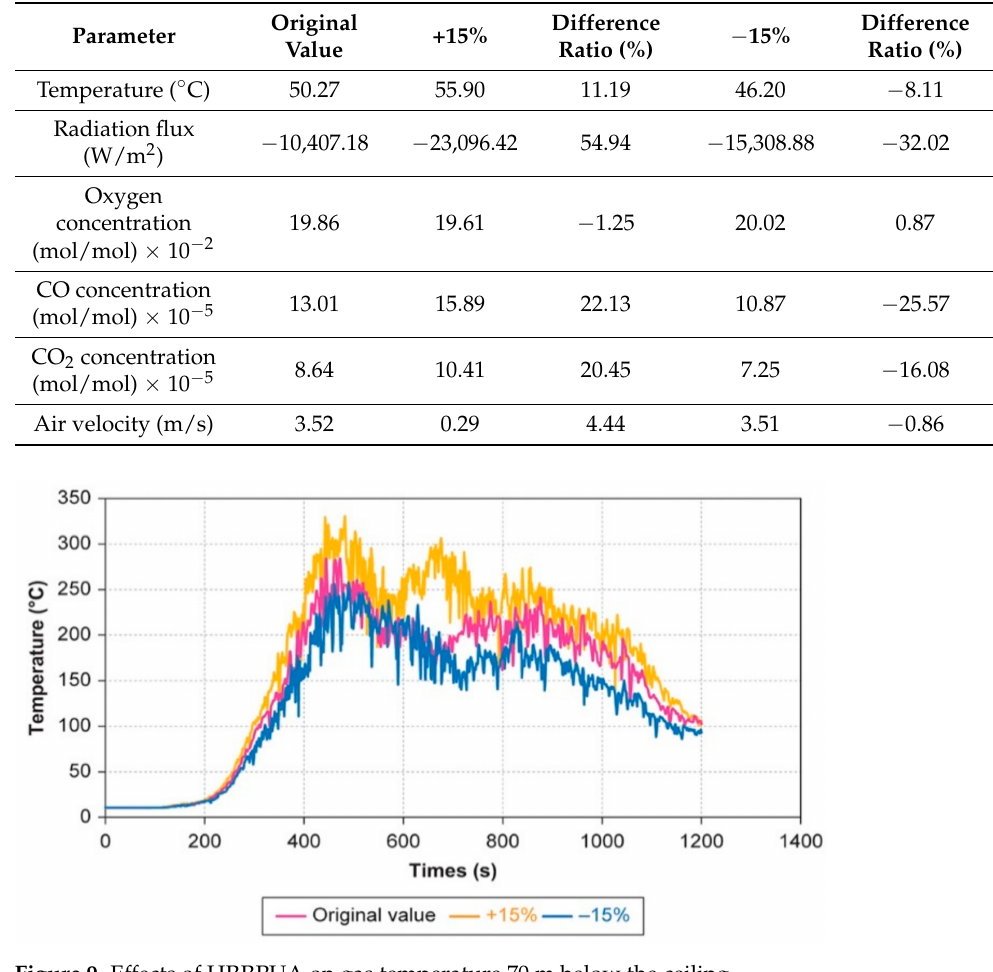
Figure 9. Effects of HRRPUA on gas temperature 70 m below the ceiling.